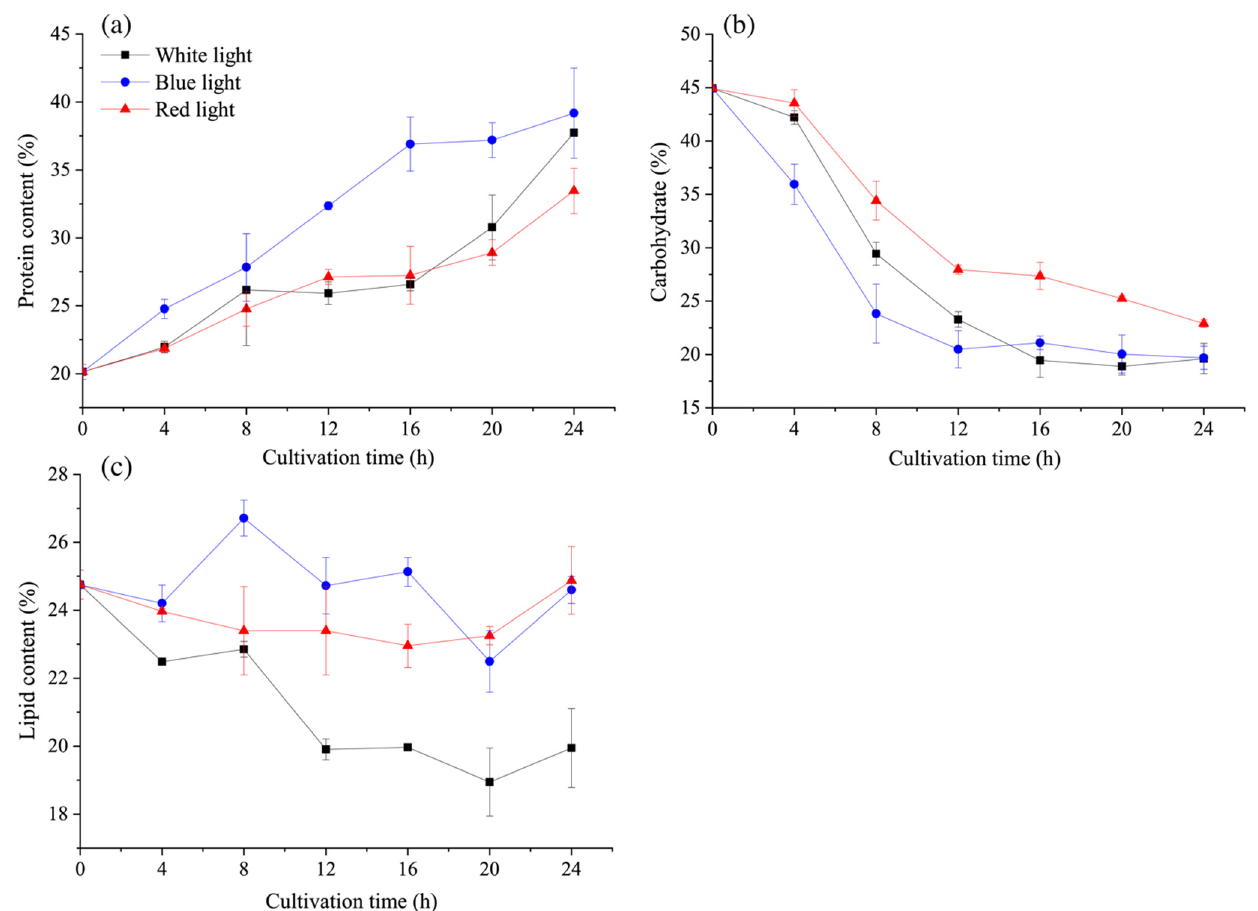
Figure 5. Effect of light wavelength on ( a ) protein content, ( b ) carbohydrate content, and ( c ) lipid content of C. reinhardtii under N ‐ recovery. Data are presented in the form of mean ± the standard deviation ( n = 3).